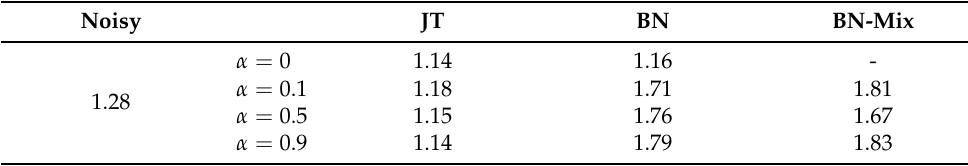
Table 3. The PESQ metric for different architectures with different α .